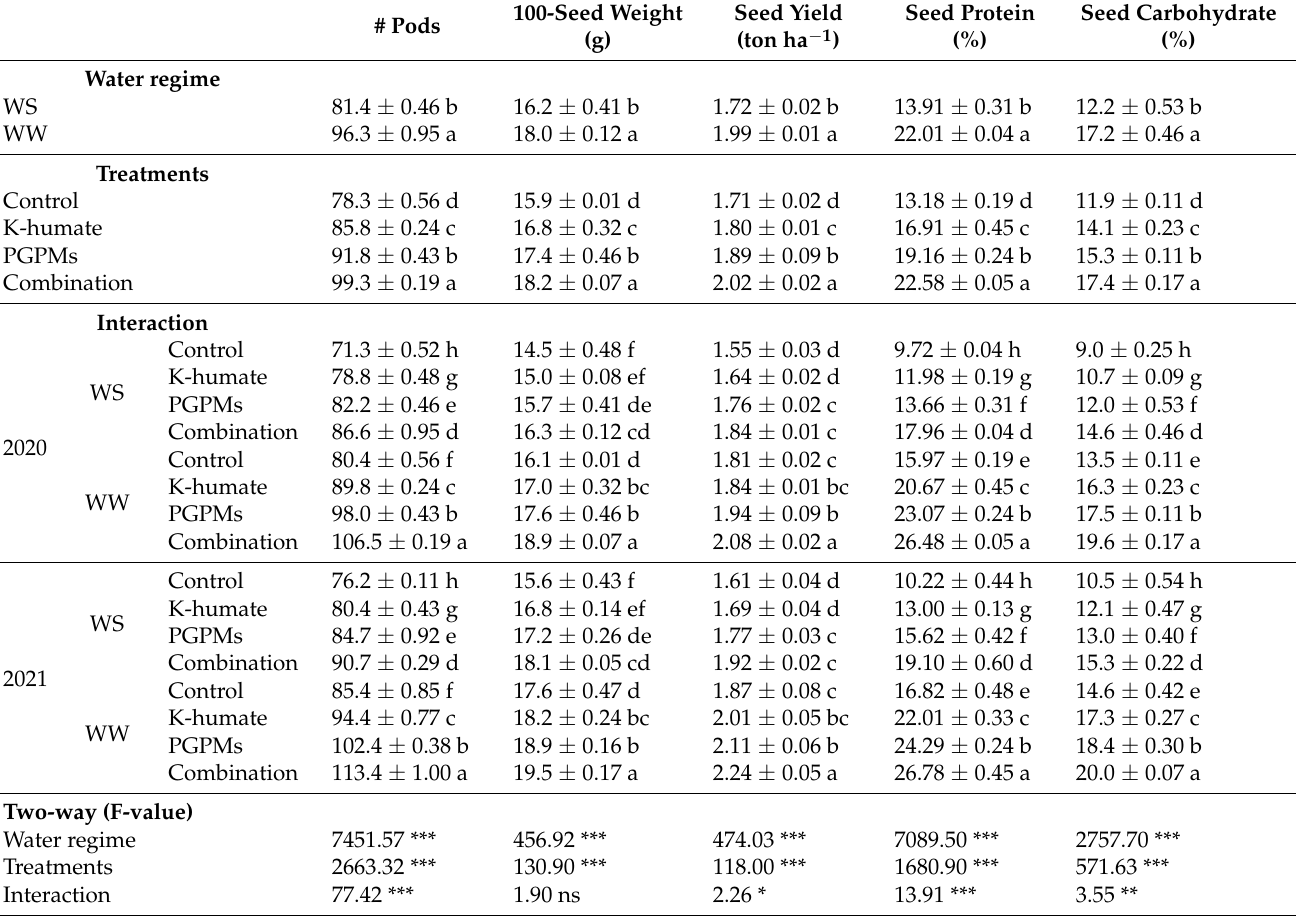
Table 3. Yield and yield-related traits of soybean seeds ( Glycine max L. cv. Giza 111) which were cultivated in salt-affected soil and treated with plant growth-promoting microbes (PGPMs; Bradyrhi- zobium japonicum (USDA 110) and Trichoderma harzianum ), potassium humate (K-humate), and their combination under two water regimes (WS: water deficit regime and WW: well-watered regime) during two consecutive